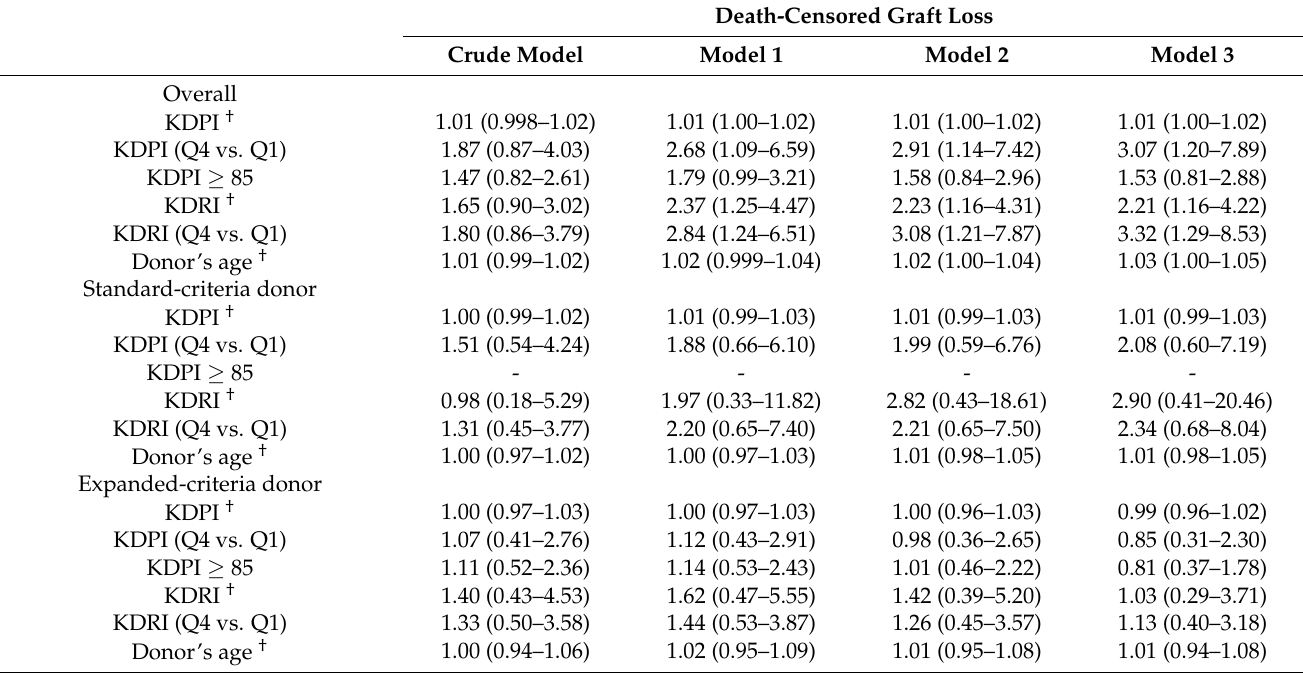
Table 3. Cox proportional hazards regression analysis evaluating the effects of KDPI, KDRI, and donor’s age on death-censored graft